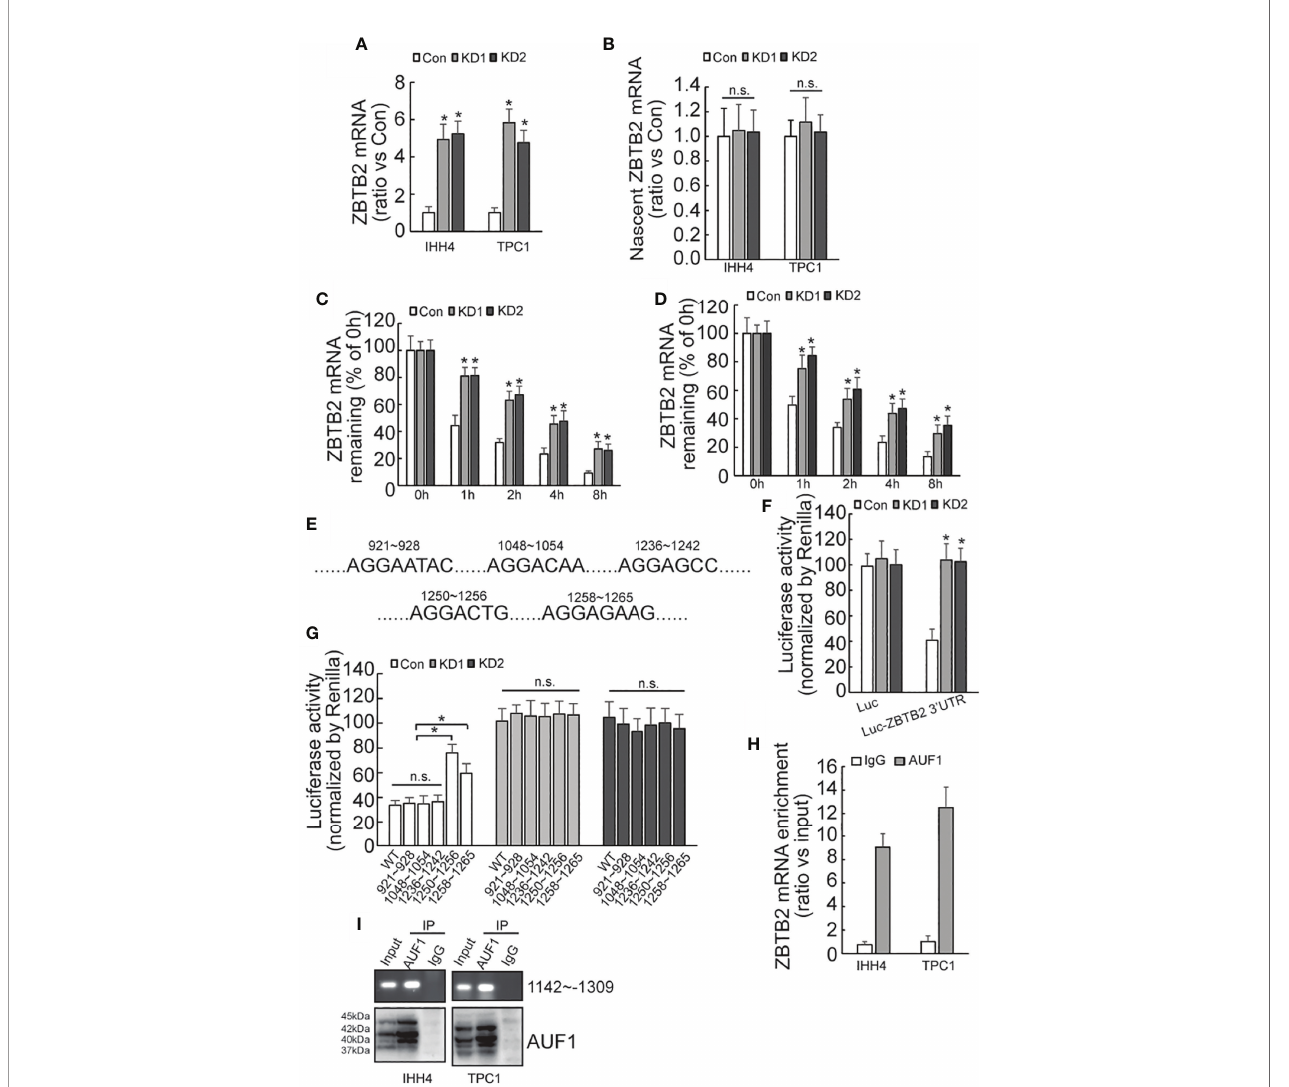
FIGURE 6 | AUF-1 affects ZBTB2 stability by binding to 3 ’ -UTR of ZBTB2 mRNA. (A) Quantitative RT-PCR detected the expression level of ZBTB2 mRNA of Con, KD1, and KD2 groups in IHH4 and TPC1 cells; (B) qRT-PCR detected the expression of ZBTB2 nascent mRNA of Con, KD1, and KD2 groups in IHH4 and TPC1 cells; (C, D) using Actinomycin D to inhibit RNA biosynthesis and explore the stability of ZBTB2 mRNA of Con, KD1, and KD2 groups in IHH4 (C) and TPC1 (D) cells; (E) fi ve potential AUF1 binding sites in the 3 ’ UTR of ZBTB2 mRNA were found via bioinformatics; (F) an increased luciferase activity was seen in KD1 and KD2 groups after constructing the 3 ’ -UTR of ZBTB2 mRNA into luciferase stop codon; (G) mutation of the luciferase reporter gene at in indicated regions and the corresponding luciferase activity was shown; (H) the enrichment of AUF1 on ZBTB2 mRNA was con fi rmed via RIP experiment; (I) Western blot was used to con fi rm the IP ef fi ciency by AUF1 antibody and agarose gel electrophoresis of PCR products of ZBTB2 3 ’ UTR was also included. N.S., not signi fi cant; n = 3, * P <